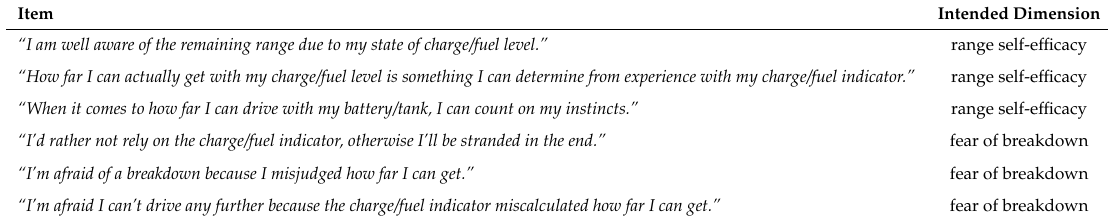
Table 1. Self-developed question items as a supplement to